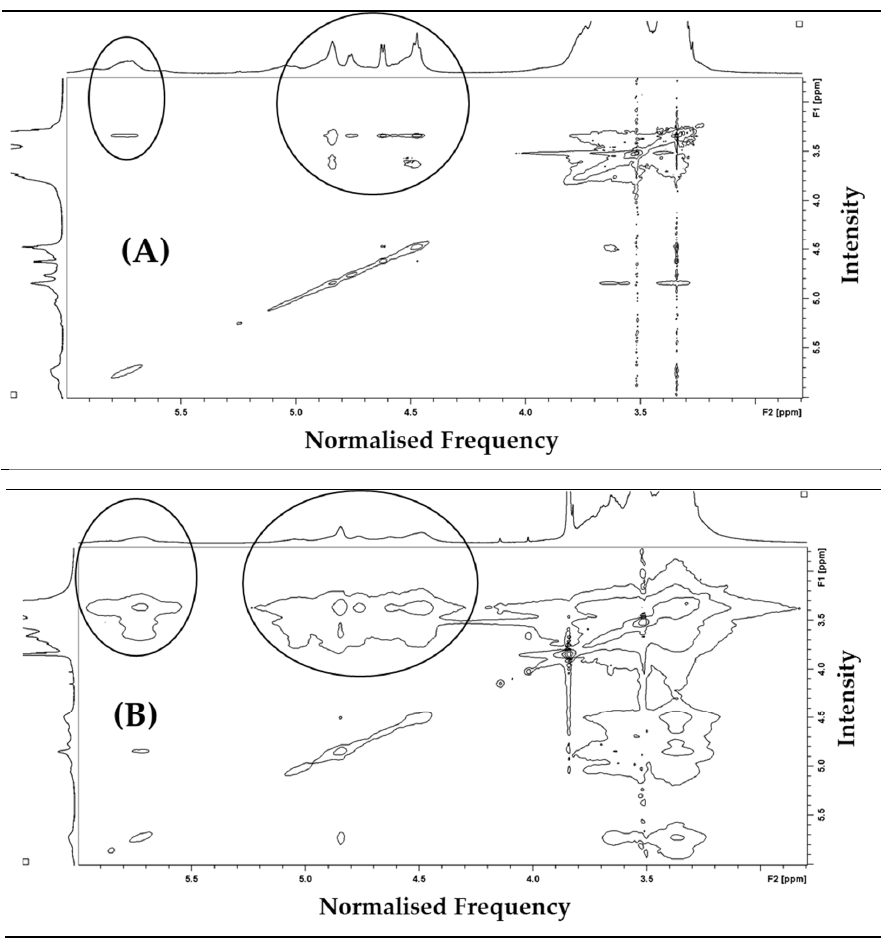
Figure 7. Comparison of 2D NMR NOESY spectra of β CPCD ( A ) and β CPCD–curcumin mixture ( B ) in DMSO-d 6 at 6.00–2.80 ppm .